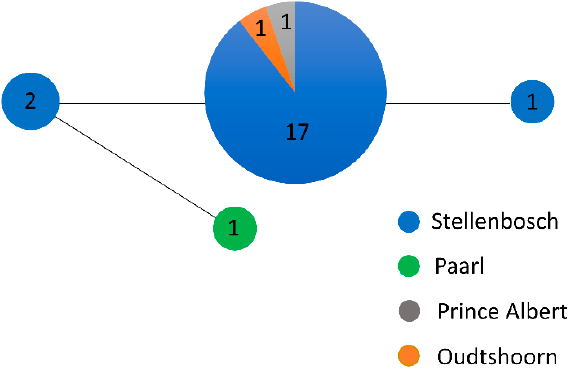
Figure 2. Median-joining network of four haplotypes found in 23 specimens of Anchonocranus oleae at four areas in the Western Cape of South Africa. The circles are proportional to the frequency of haplotypes, and the length of the lines represents one mutational step between the haplotypes.